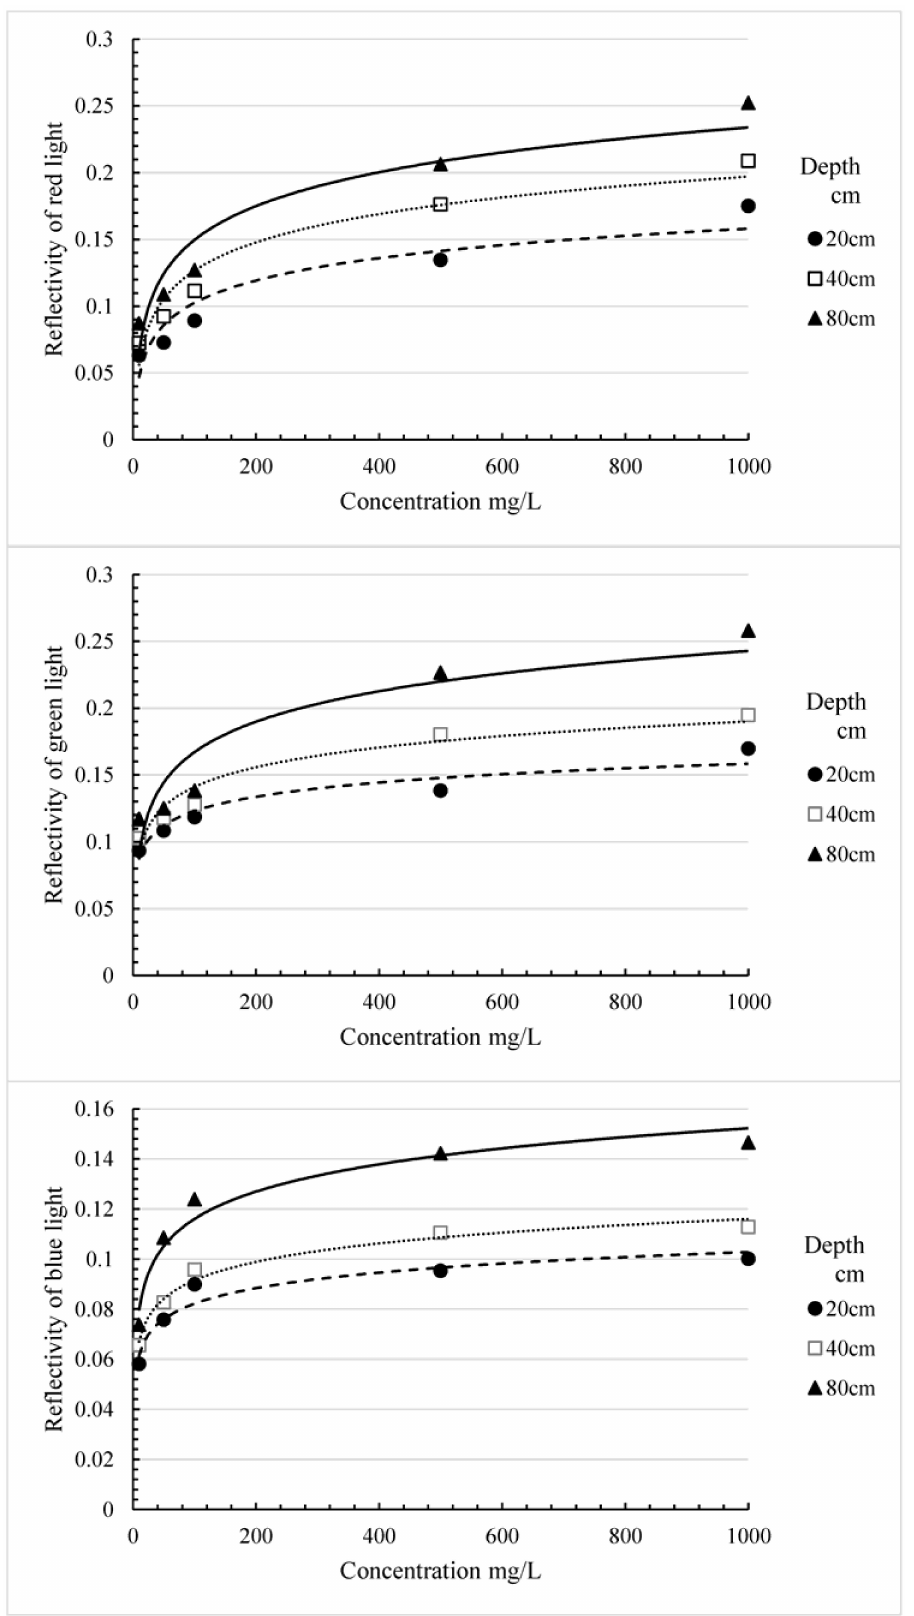
Figure 5. Curves of chromatic light tricolor reflectance with sediment concentration at different depths of